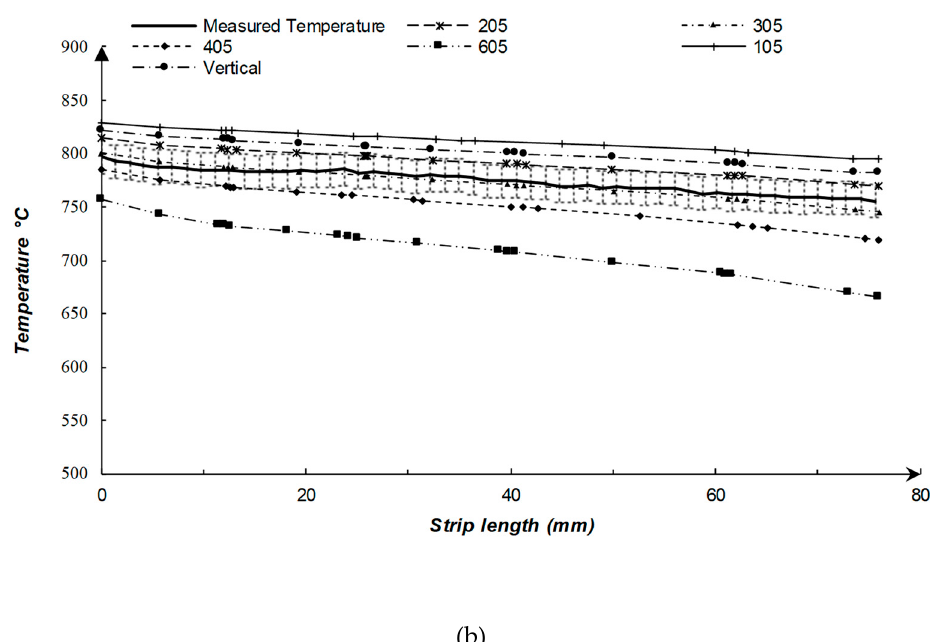
Figure 5. Validation of assumed boundary condition for the bath size and the placement. ( a ) Schematic view of the bath with different size and placement of boundary condition; ( b ) temperature results.